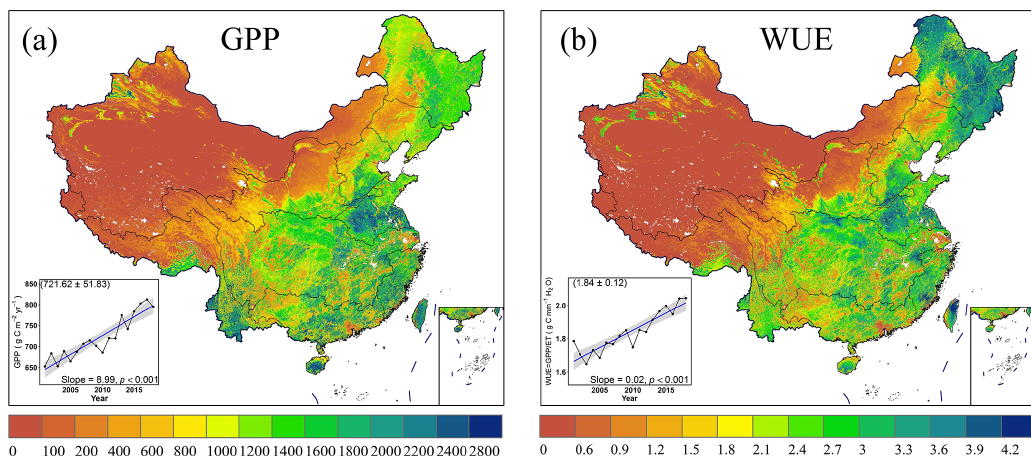
Figure 11. Spatial pattern of mean annual GPP, WUE and their annual variation during 2001–2018. In all the insets, the shaded areas repre- sent the 95% confidence interval based on the linear regression modeling. The number in the parentheses of each inset is mean ± standard deviation of the annual simulated variables during the 18